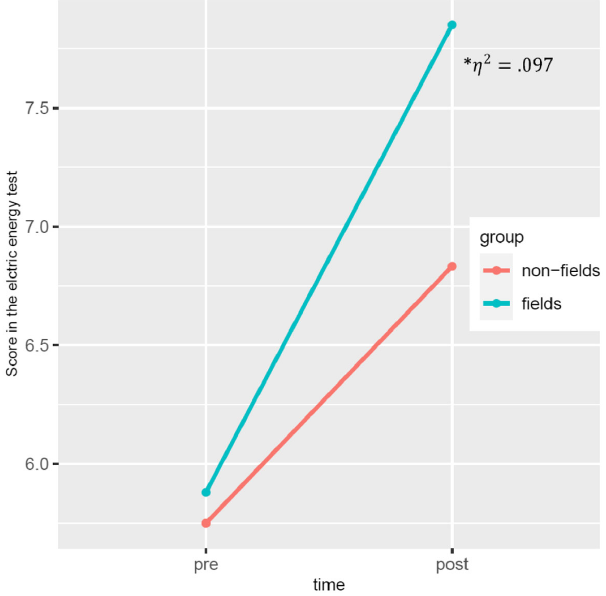
FIG. 5. Students mean scores on the electric energy test before (pre, T3) and after (post, T4) the subsequent unit for both groups.